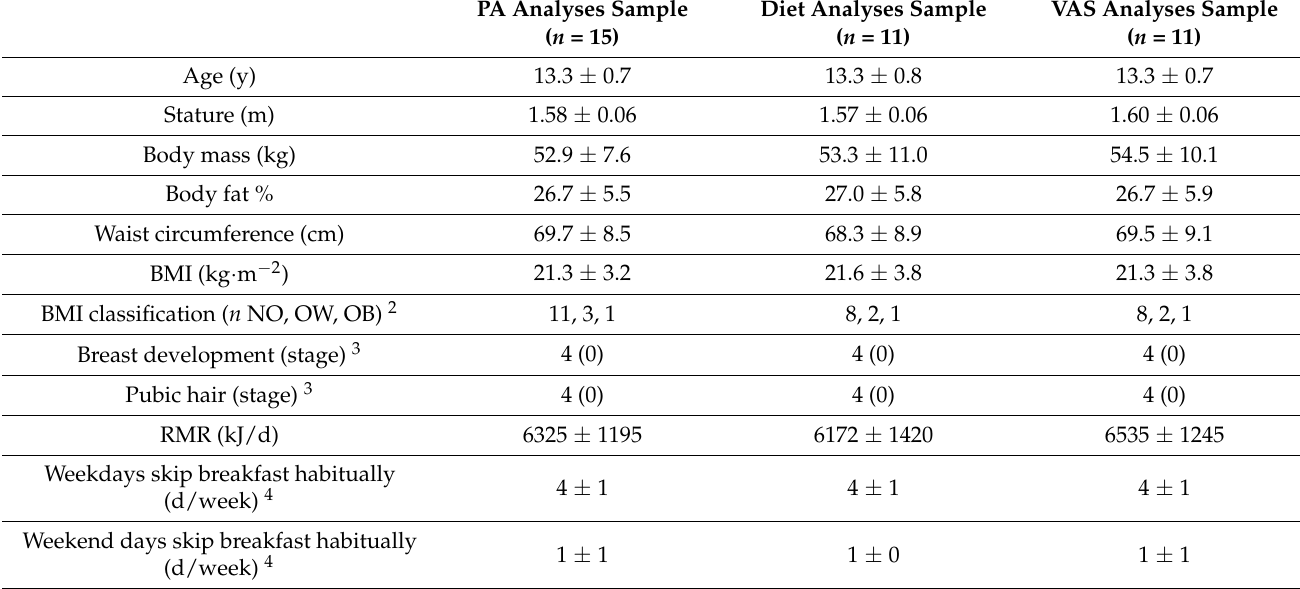
Table 2. Nutrient content of the breakfast providing 25% of individual resting metabolic rate to adolescent girls who participated in the randomised crossover trial that compared seven days of daily breakfast consumption (BC) with seven days of breakfast omission (BO) 1 .